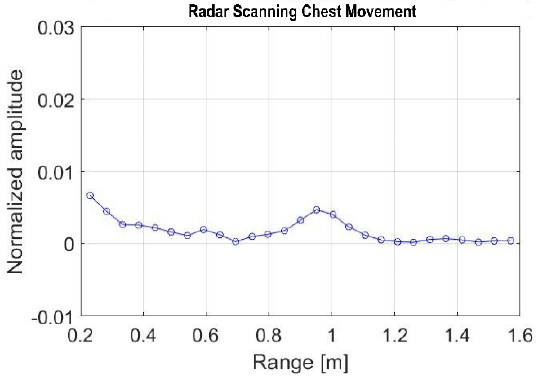
Figure 3. Radar signal during chest scanning.